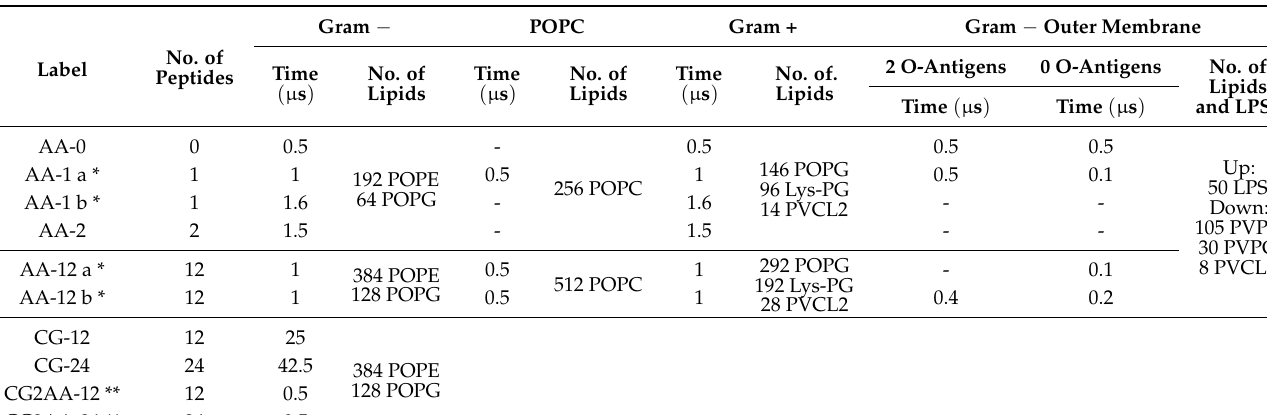
Table 1. Summary of the MD